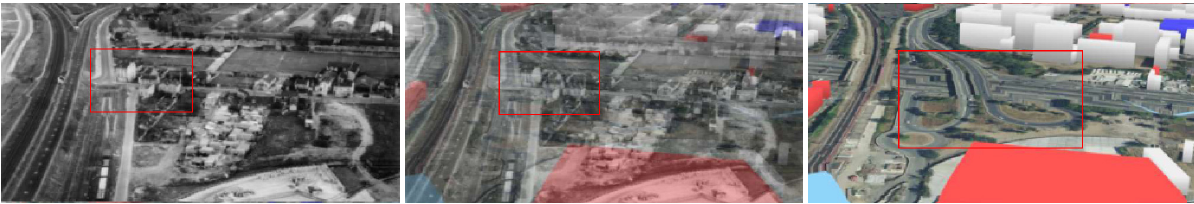
Figure 12. Interaction between a photograph (left) and the 3D scene (right) through transparency (middle). Infrastructure evolution and (dis)appearance of landmarks (hotel/restaurant vs highway interchange) are highlighted ( c (cid:13) AD92, period